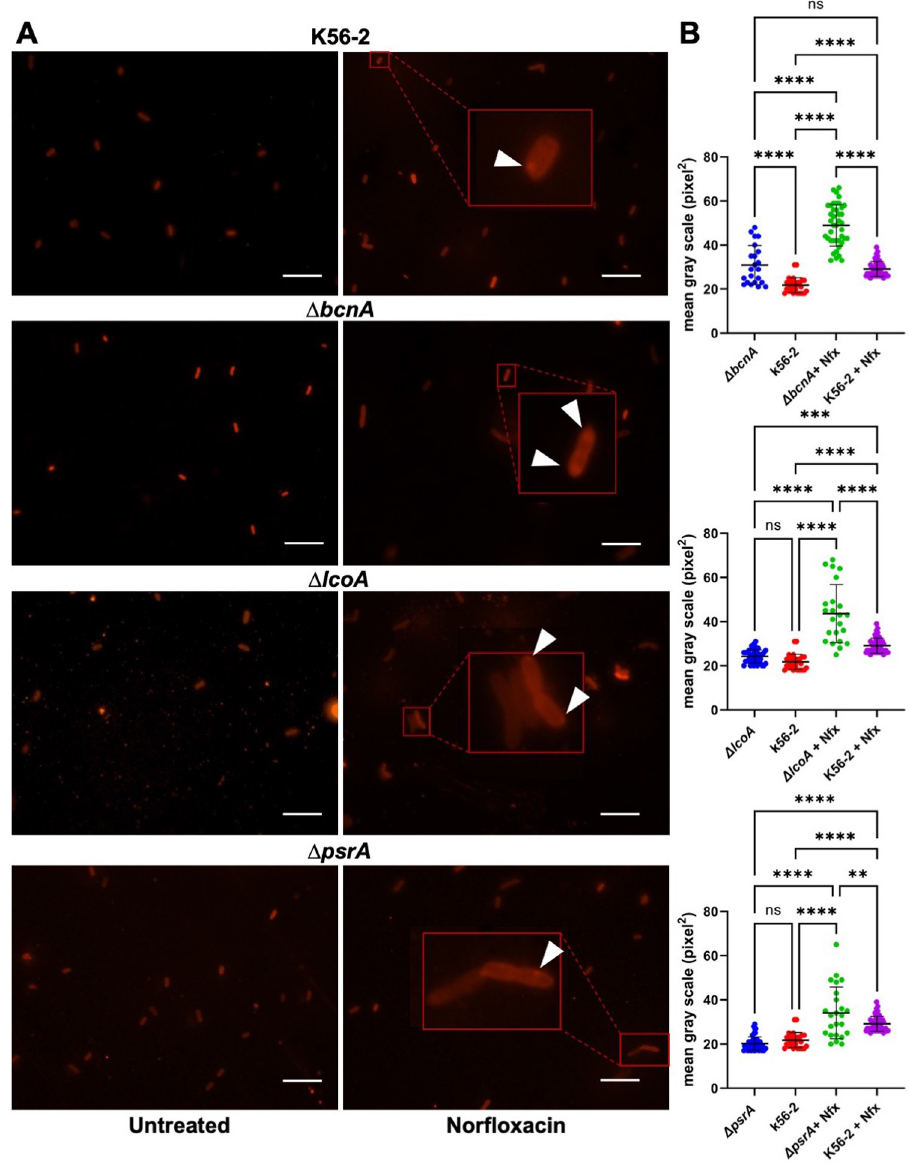
Fig 4. Anionic phospholipid detection by fluorescence microscopy. (A) Upon treatment with 1 μ M NAO for 15 minutes at room temperature, bacteria were examined with a Zeiss microscope using a 100 × oil immersion lens with an excitation at 640 nm. Arrowheads indicate the polar accumulation of fluorescence in bacterial cells poles. Scale bars, 10 μ m. (B) Quantification of fluorescence intensity by ImageJ; the results represent the mean ± SD from 3 independent experiments. The statistical significance was determined by 1-way ANOVA with Tukey multiple comparisons test’s post hoc analysis. ���� , p < 0.0001; ��� ; p < 0.001; ns, nonsignificant. Data underlying the graphs in this figure can be found in S2 Data. NAO, Acridine Orange 10-nonyl bromide; SD, standard